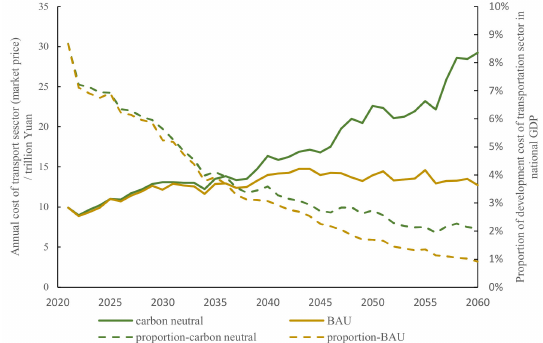
Figure 11. The costs of decarbonisation in the transport